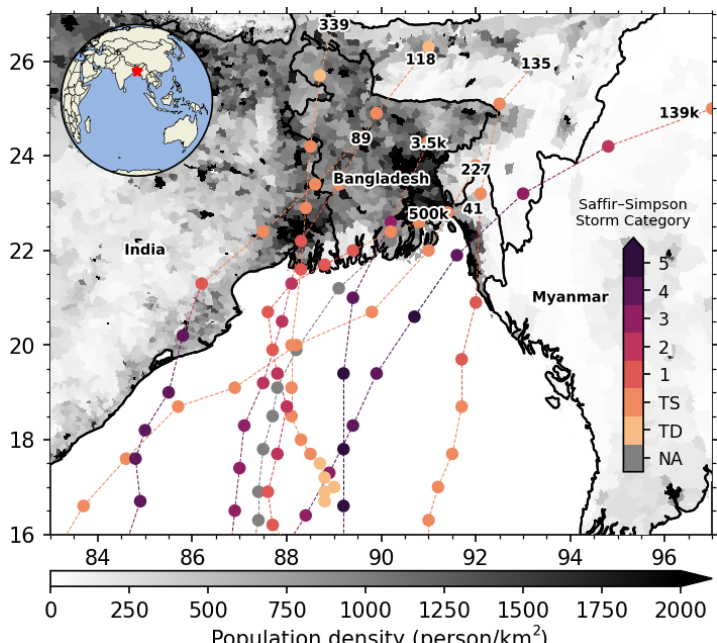
Figure 1. Population density in the Bengal delta covering Bangladesh and India. A subset of cyclone tracks that made landfall in past decades is displayed as dashed lines. Inset shows the location of the study area. The colour-coded lines show the cyclone strength along its track on the Saffir–Simpson scale. TD and TS correspond to tropical depression and tropical storm, respectively. For the 1970 Bhola cyclone, the wind speed is not available (NA) and is shown in grey. The associated number at the head of the cyclone tracks refers to the number of